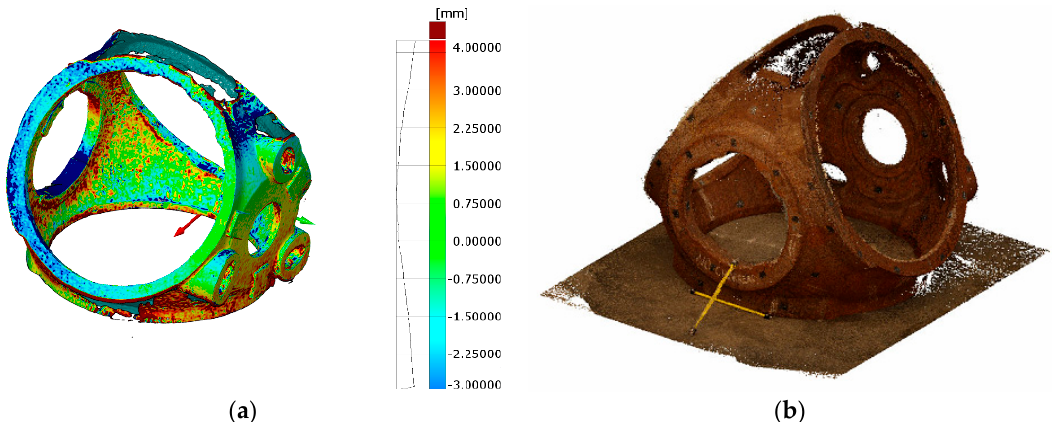
Figure 14. 3D representation of measured part in shop-floor environment: ( a ) surface point comparison against reference mesh; and ( b ) dense point cloud with color and texture information (full resolution).